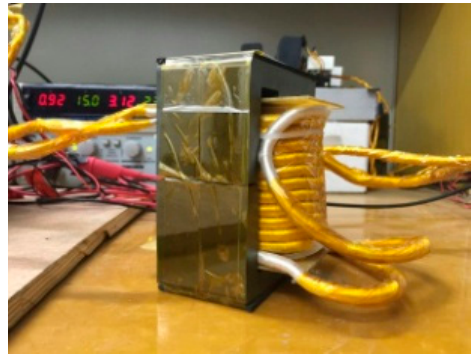
Figure 16. High-frequency LLC transformer.